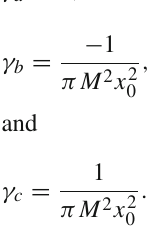
, and c ) γ c = 1 /π M 2 x 2 0 0